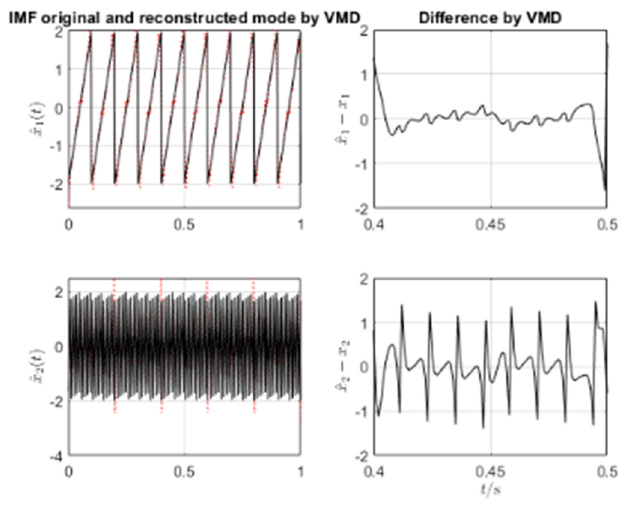
Figure 9. VMD decomposition of 𝑥 (cid:2903)(cid:2919)(cid:2917)(cid:2872) (𝑡) .